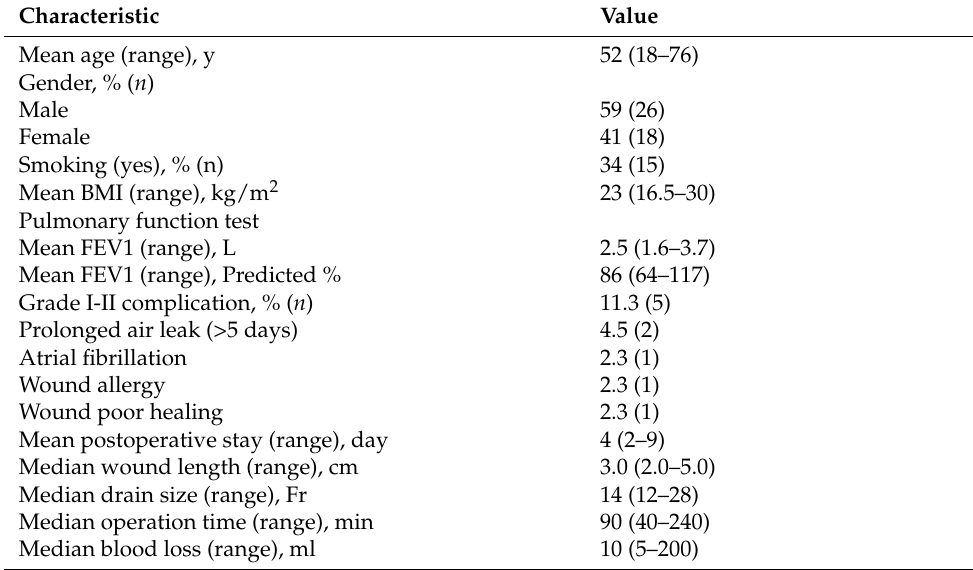
Table 3. Characteristics of enrolled patients ( n =